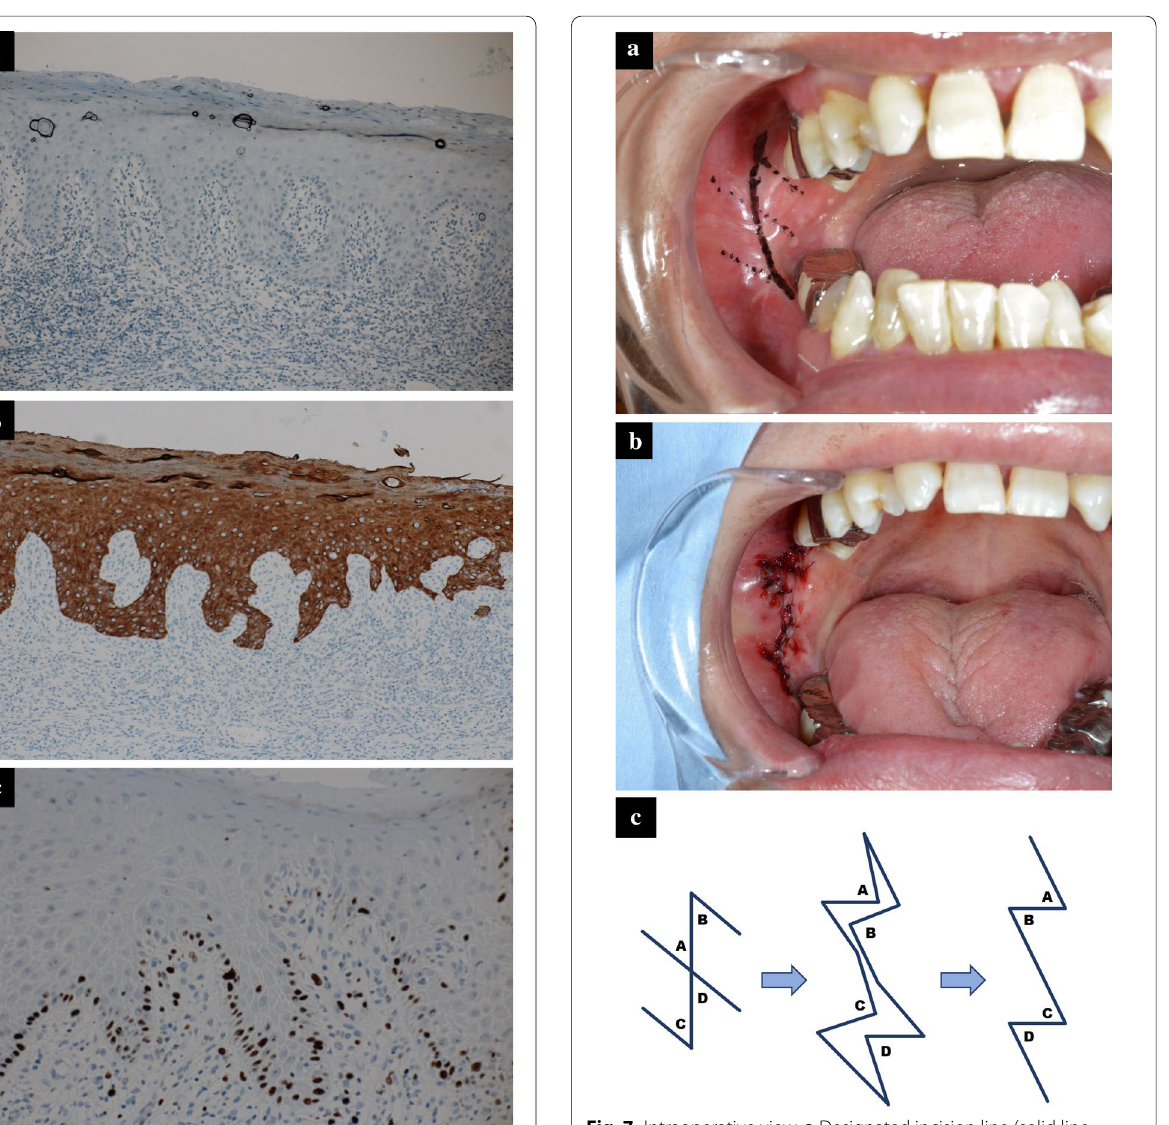
Fig. 6 Immunohistochemical staining results were negative for cytokeratin 13 ( 100) ( a ), positive for cytokeratin 17 within the × epithelium layer ( 100) ( b ), and positive for Ki-67/MIB-1 primarily in × the basal layer ( 200) ( c ) ×